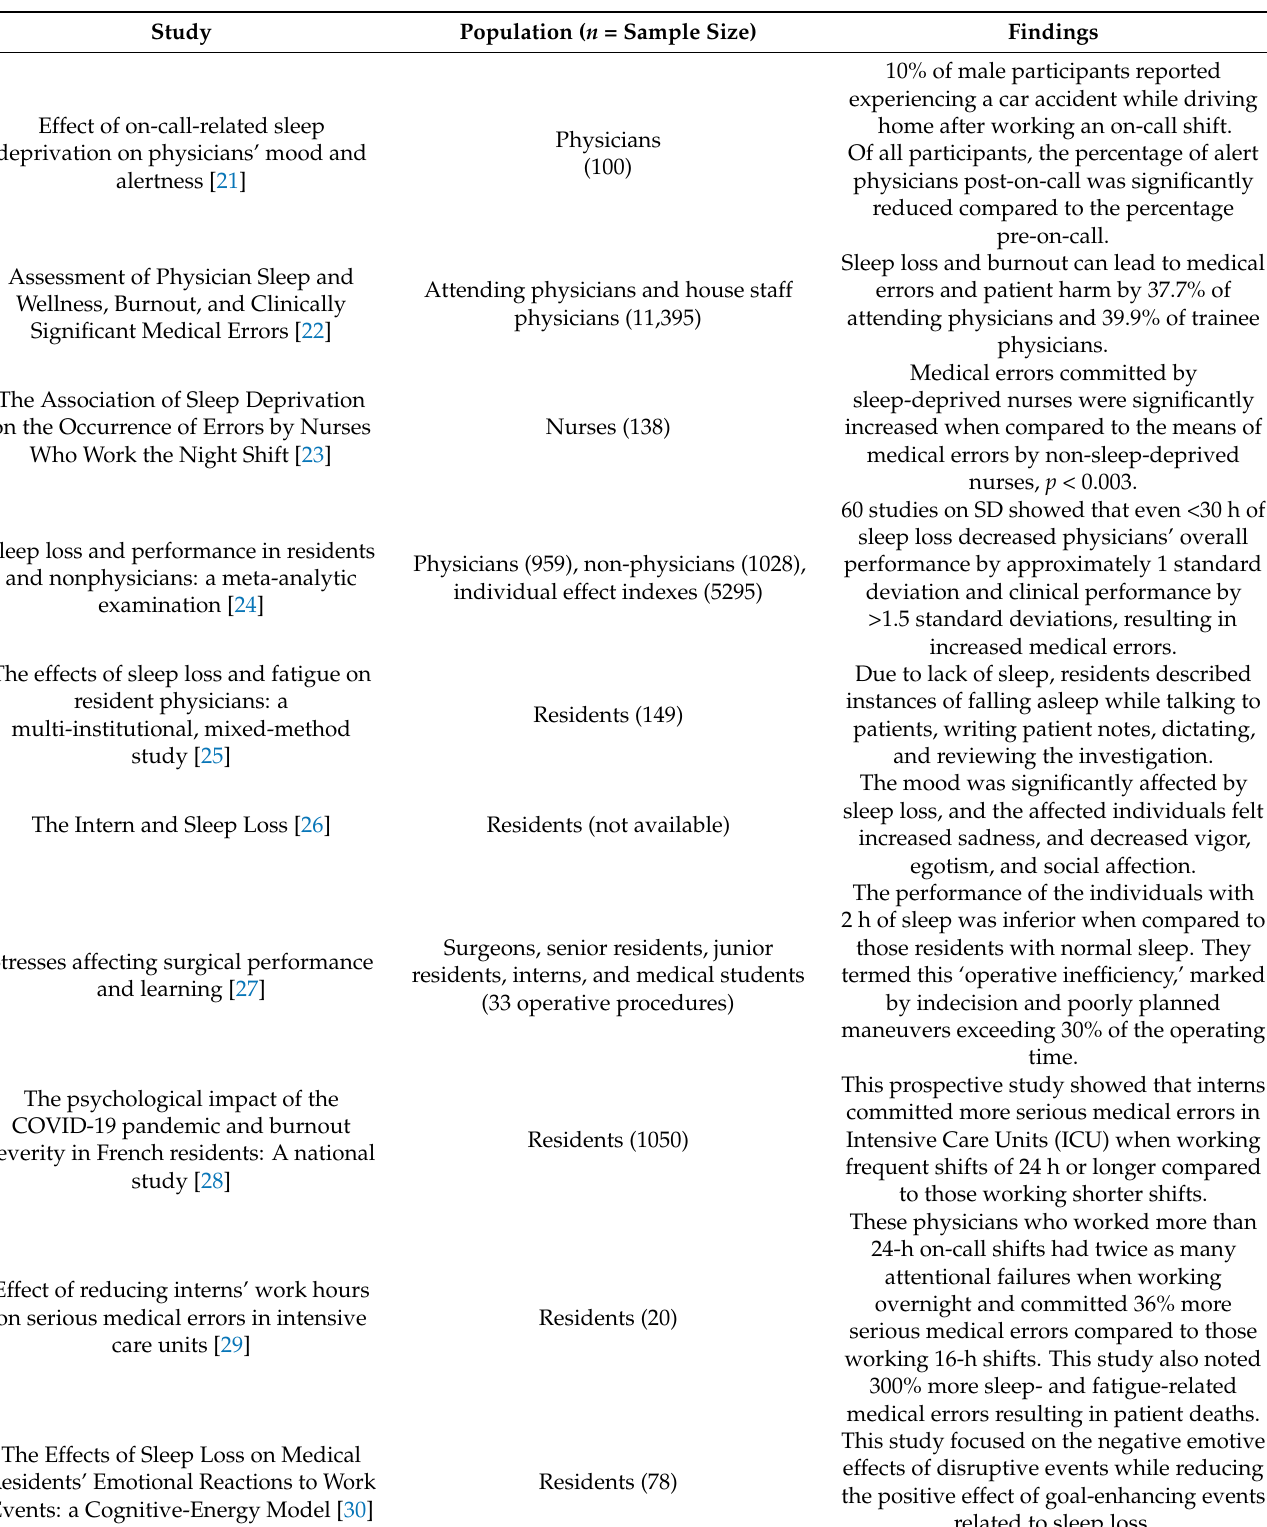
Table 1. Adversities of SD in healthcare